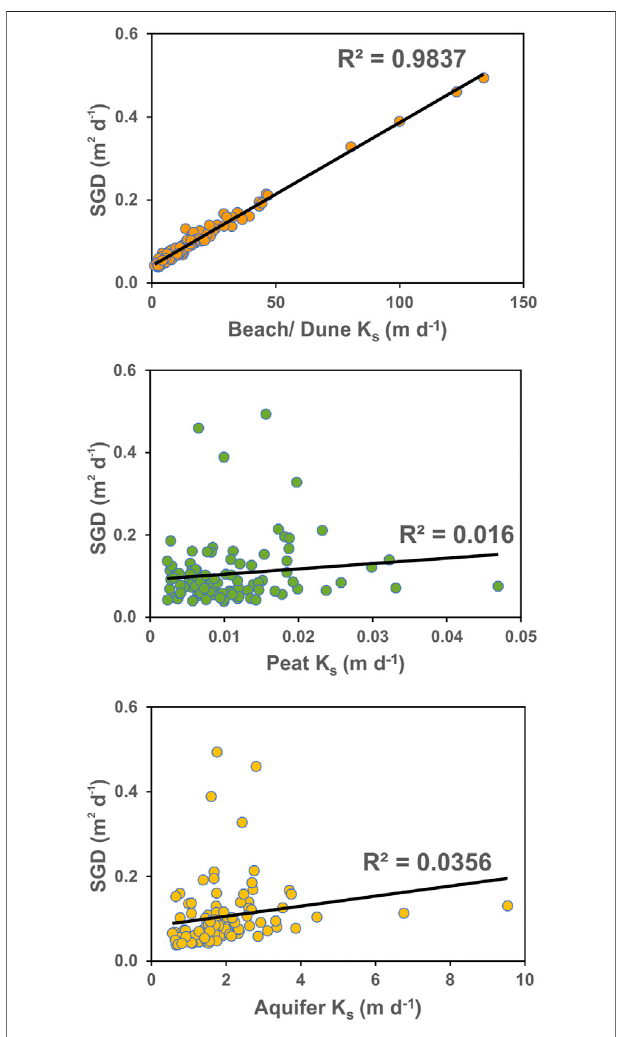
FIGURE 7 | Linear regressions of SGD and material K s , K s data generated for uncertainty analysis. Beach/dune sands K s is highly correlated with